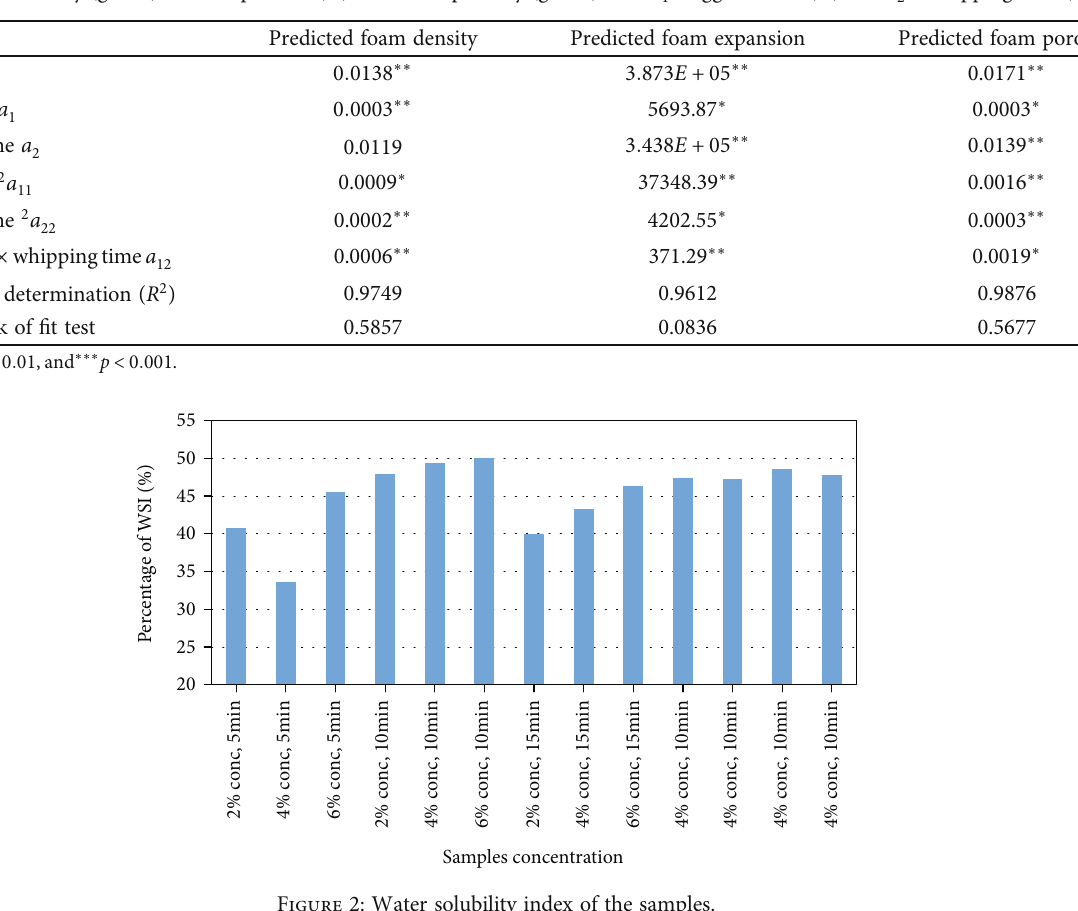
Table 2: Regression coe ffi cients, coe ffi cient of determination ( R 2 ), and lack of fi t values for the second-order fi tted models corresponding responses, foam density (g/cm 3 ), foam expansion (%), and foam porosity (g/cm 3 ) with x